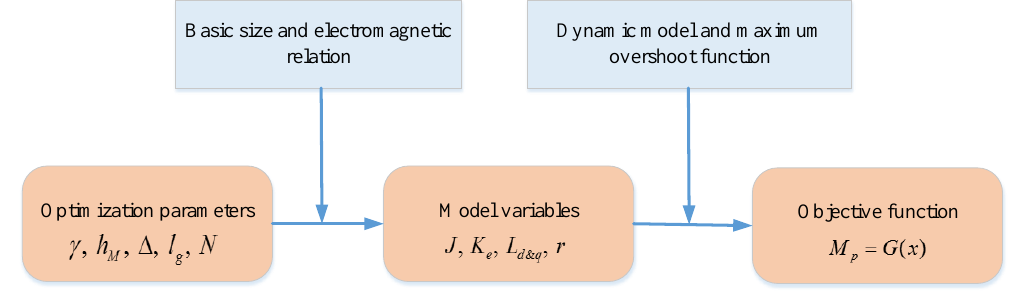
optimization once at a time or simple superposition optimization is not enough to achieve the optimal